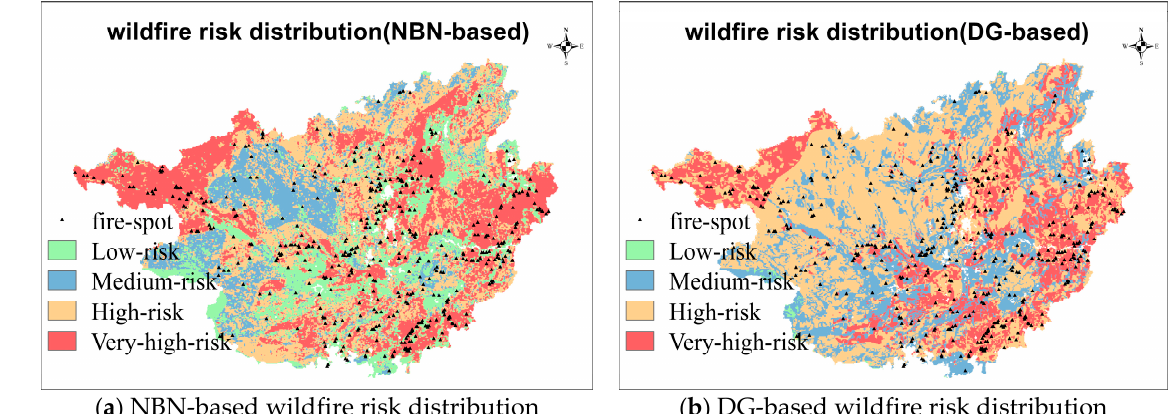
Figure 6. Wildfire risk distribution in Guangxi province.